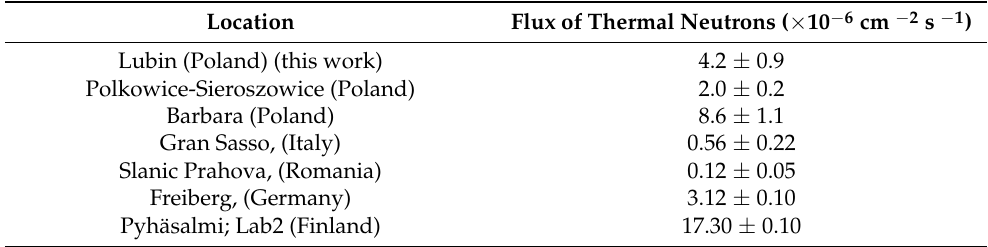
Table 4. Comparison of thermal neutron flux measurement in different European underground locations.